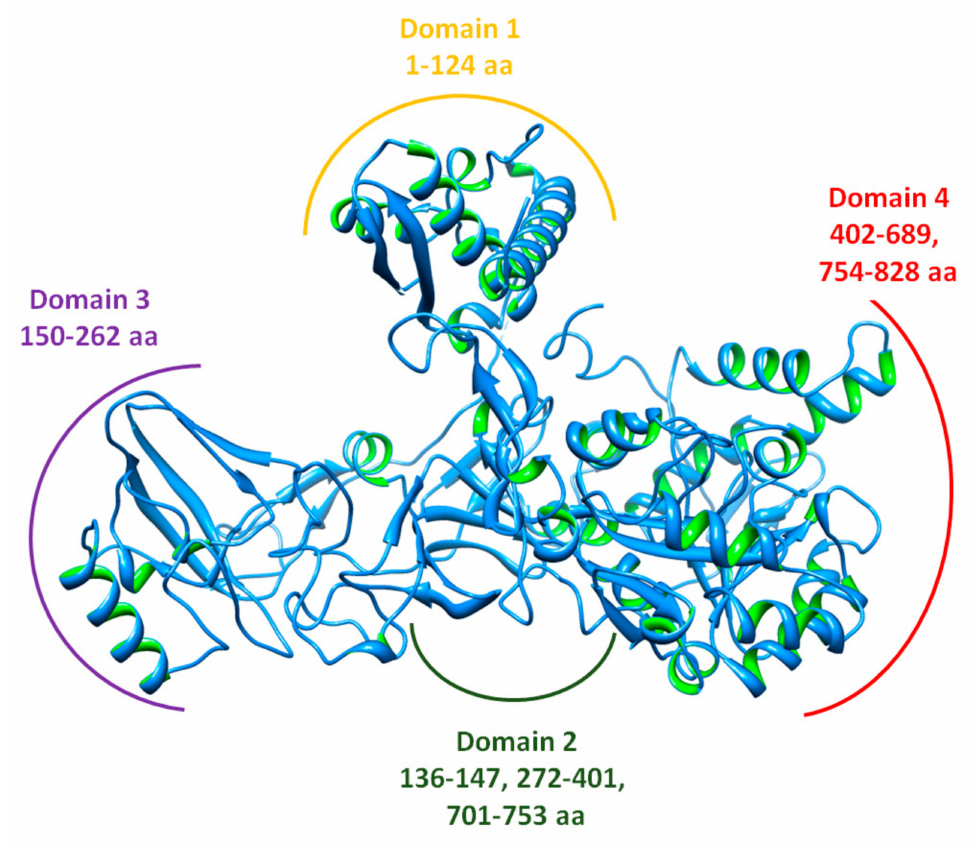
Figure 4. Protein structure with domain residues.